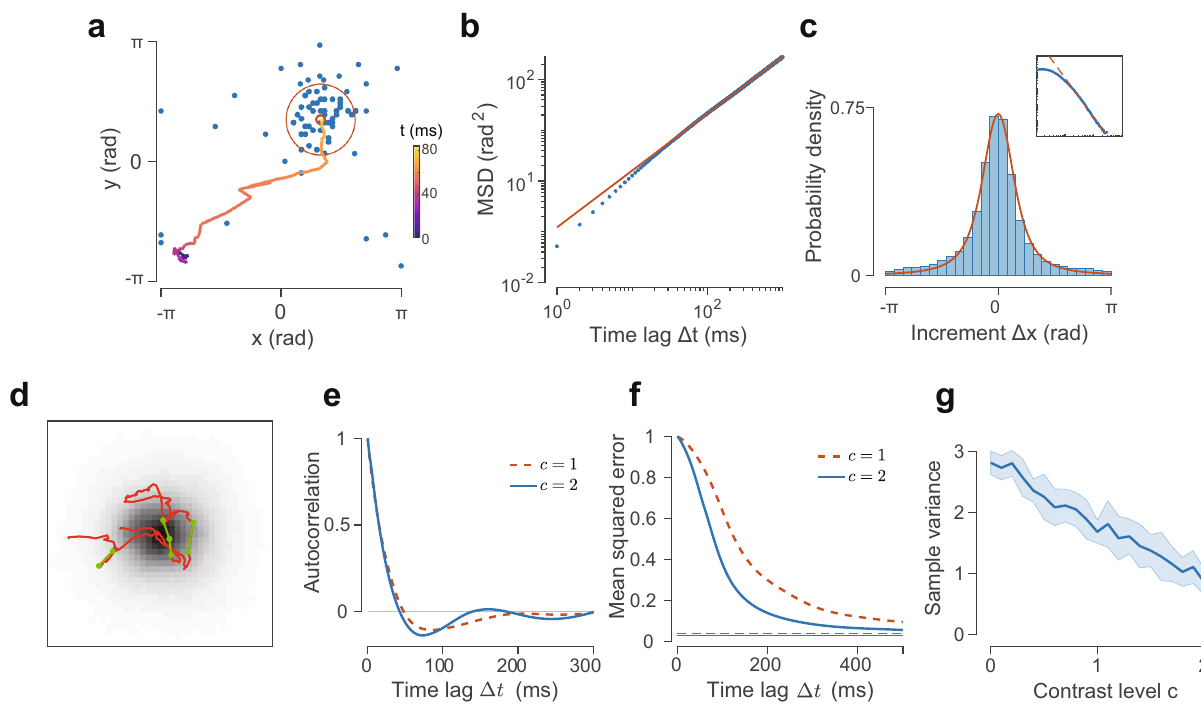
Fig. 2 | Spatial and temporal properties of FNS. a Snapshot of the localized activity pattern when the I – E ratio ξ = ξ c =3.4. Dots denote spikes during a 5ms period. The small circle marks the center-of-mass (CoM) of the pattern and the largecirclerepresentsonestandarddeviationofthespikelocations.Thelineshows the CoM trajectory of the pattern over the previous 80ms, with color indicating time. b Mean squared displacement (MSD) of the trajectory of the activity pattern asa function of time lag. The red line indicates a power-law fi t, MSD( Δ t ) ∝ Δ t η , with thediffusionexponent η =1.18. c Distributionoftrajectoryincrements.Theredline indicates a fi tted symmetric α -stable distribution, with the tail index α =1.28. Inset: